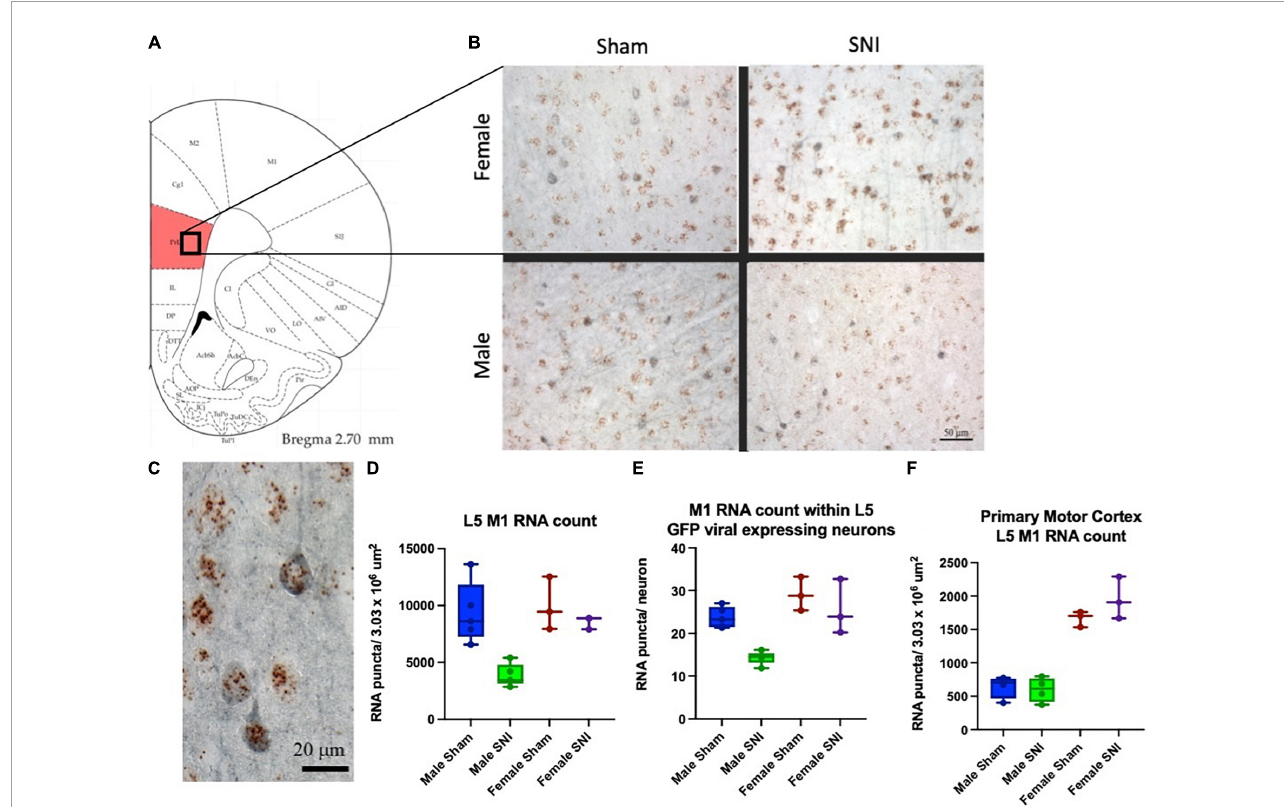
FIGURE4 M1 expression in the PLC is differentially regulated in males and females. (A) Schematic representing the cortical area analyzed. (B,C) In situ hybridization for M1 RNA (brown dots) combined with immunohistochemistry targeting EGFP (blue) to identify PLC commissural neurons. One week after peripheral surgery, M1 RNA density in PLC L5 was reduced in male SNI animals compared to Sham ( D ; male SNI vs. sham, p = 0.003; female SNI vs. sham p = 0.36). When the quantification was limited to L5 commissural projecting neurons (eGFP positive neurons, blue), M1 RNA expression in SNI was also significantly reduced in male, but not female, rats [ (E) , male SNI vs. sham, p ≤ 0.0001; female SNI vs. sham p = 0.46; two-way ANOVA]. (F) Control data were obtained in the same sections from the adjacent primary motor cortex and did not show any SNI-dependent change in M1 RNA expression (although there was a major sexual dimorphism in both control and SNI). Data from eight males (four Sham and four SNI) and six females (three Sham and three SNI); data points overlap in some